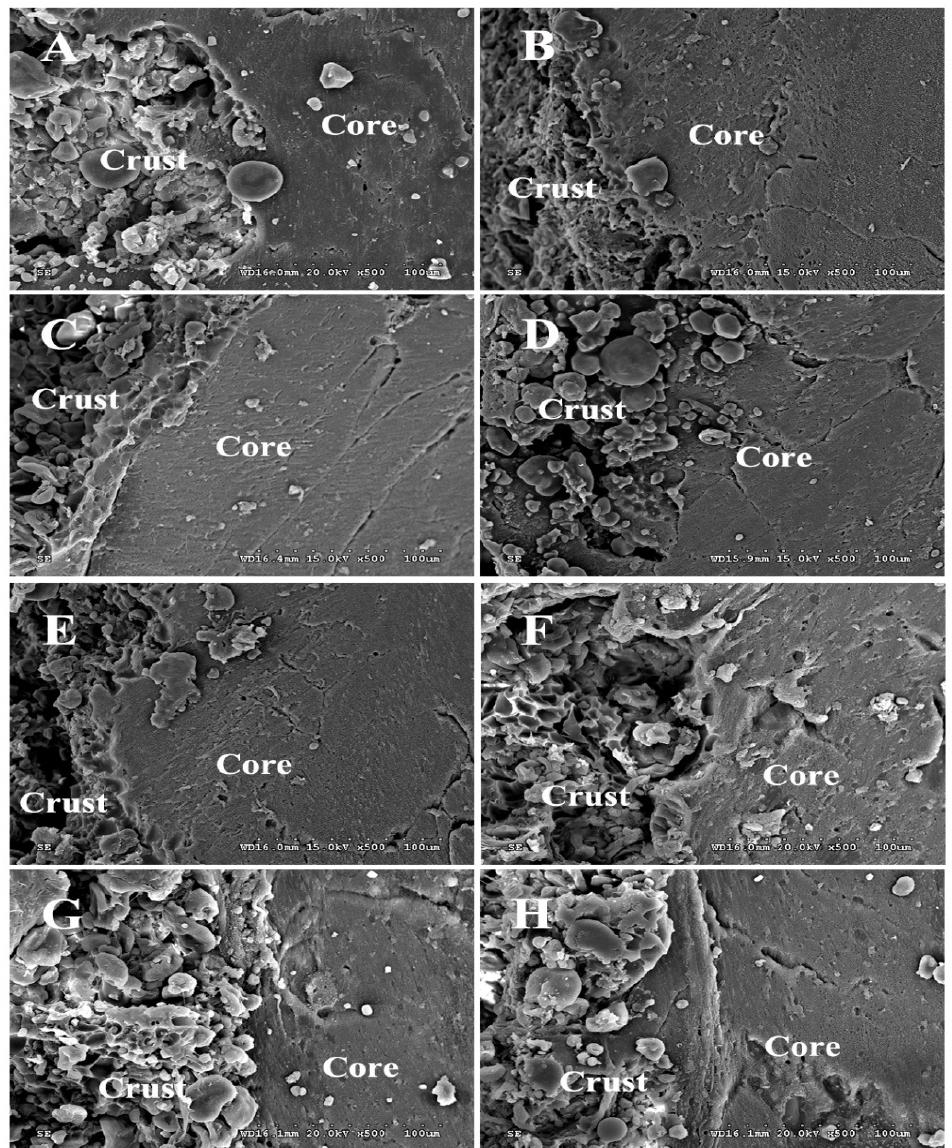
Figure 2. SEM micrographs of fried BBFNs using fresh and preheated frying oils. All the images were taken at 500 × magnification. ( A ) Fresh rapeseed oil; ( B ) preheated rapeseed oil; ( C ) fresh soybean oil; ( D ) preheated soybean oil; ( E ) fresh rice bran oil; ( F ) preheated rice bran oil; ( G ) fresh palm oil; and ( H ) preheated palm oil.